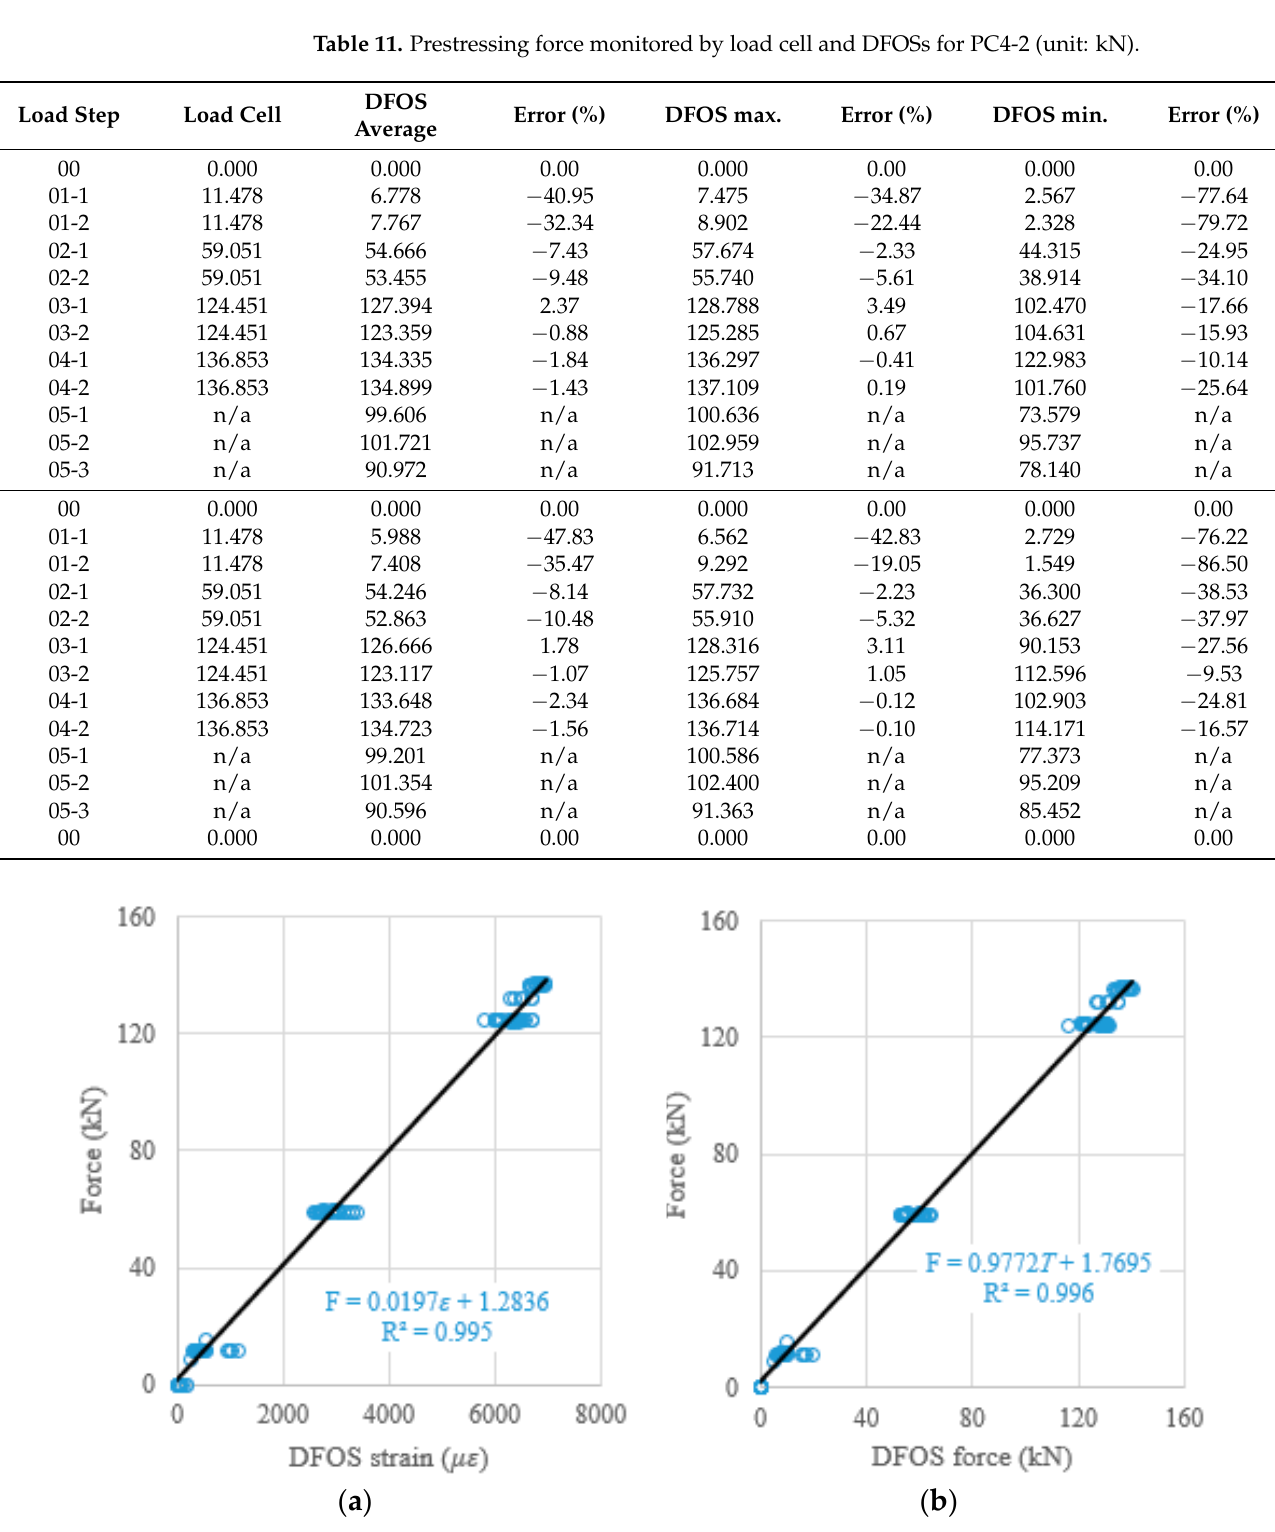
( b ) Figure 16. ( a ) Prestressing force versus DFOS-max. strain; and ( b ) prestressing force versus DFOS max. strain-calculated force.